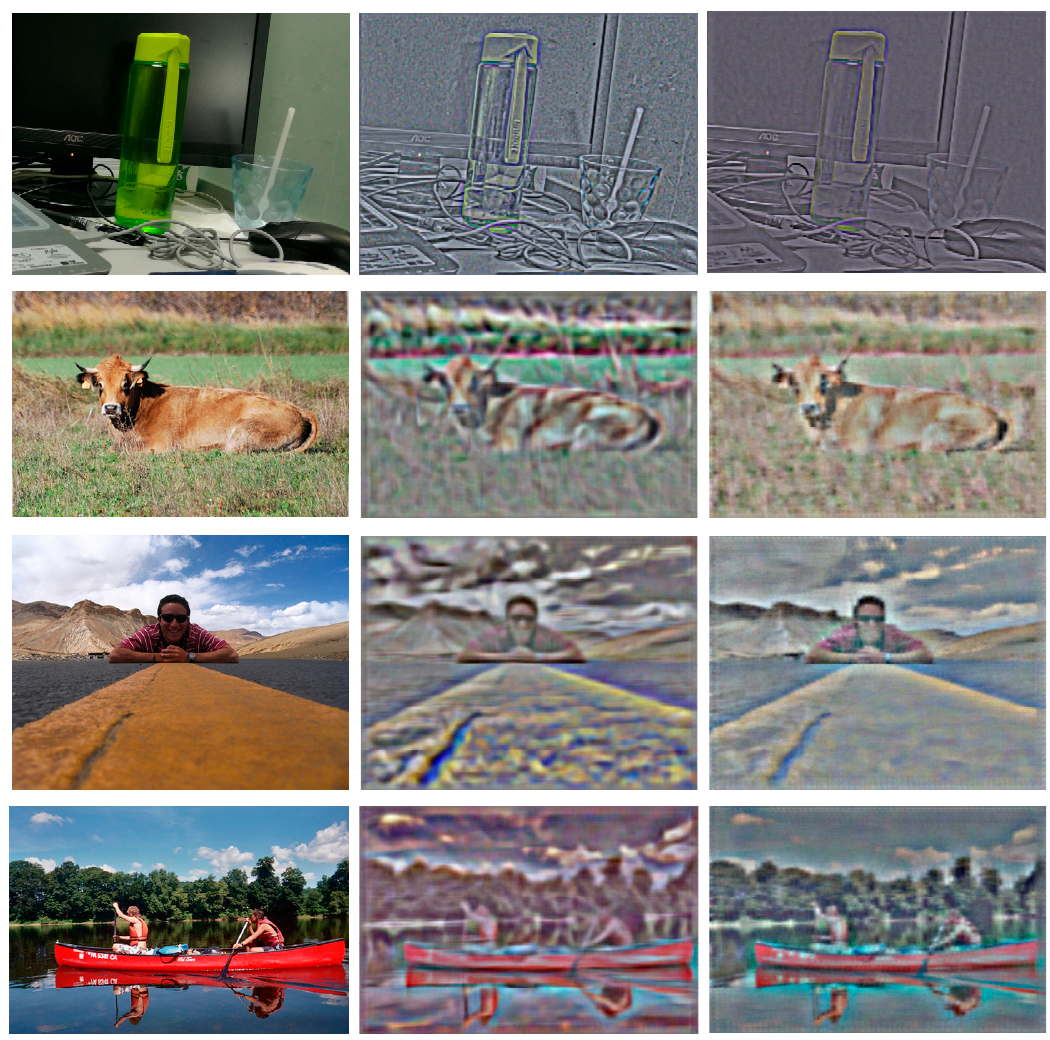
Figure 7. Comparison of the visualization results of HOG and HOGP features. The first column is the original image, the images in the second column are visualized by the HOG features, and the images in the third column are visualized by the HOGP features.